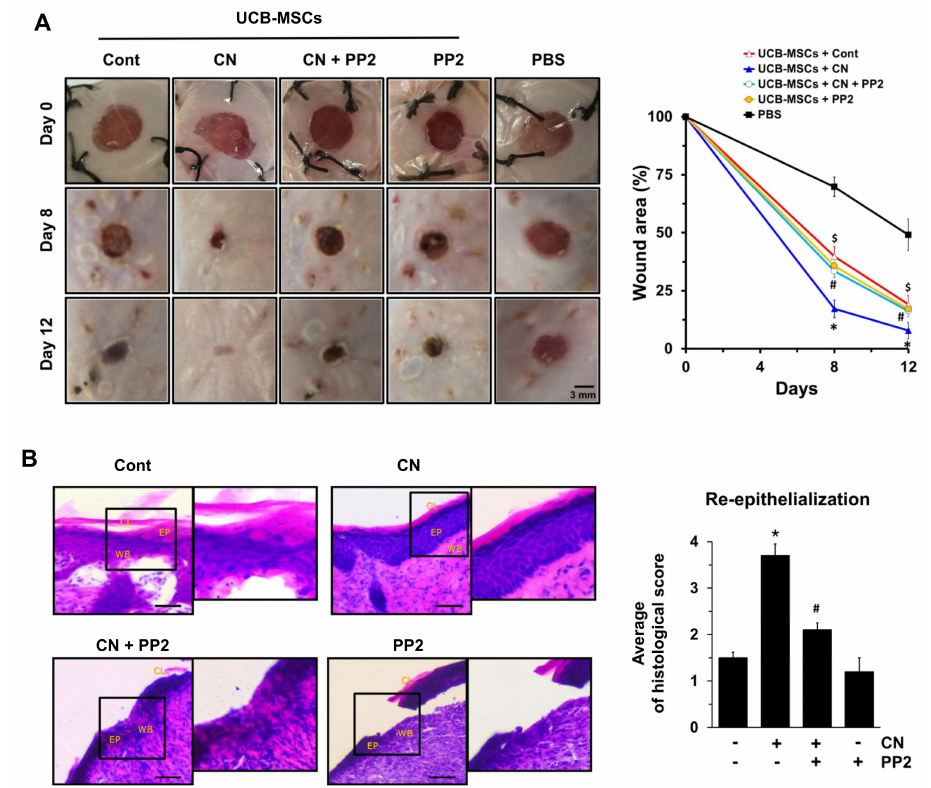
Figure 6. The role of CN in mouse model for skin wound healing. ( A ) Representative gross images on skin wound healing on day 0, 8, and 12 are shown (left panel). Mouse skin wounds were made by 6-mm-diameter biopsy punch. For the stem-cell implantation, mice were given PBS alone or UCB-MSCs treated with Cont, CN, CN + PP2, and PP2. Quantifications of wound sizes relative to original wound size for 12 days are shown. Data represent the mean ± S.E. n = 8. $ , p < 0.01 vs. PBS alone. * p ≤ 0.01 vs. cont. # p ≤ 0.05 vs. CN alone. ( B ) Representative wound tissues stained with H&E on day 12 are shown (left panel). Scale bars, 100 µ m. Abbreviations: EP, epidermis; WB, wound bed; CL, cornified layer. Histological scores in re-epithelialization (right panel) were quantified according to the Table 1. Data represent the mean ± S.E. n = 8. * p ≤ 0.001 vs. cont. # p ≤ 0.01 vs. CN